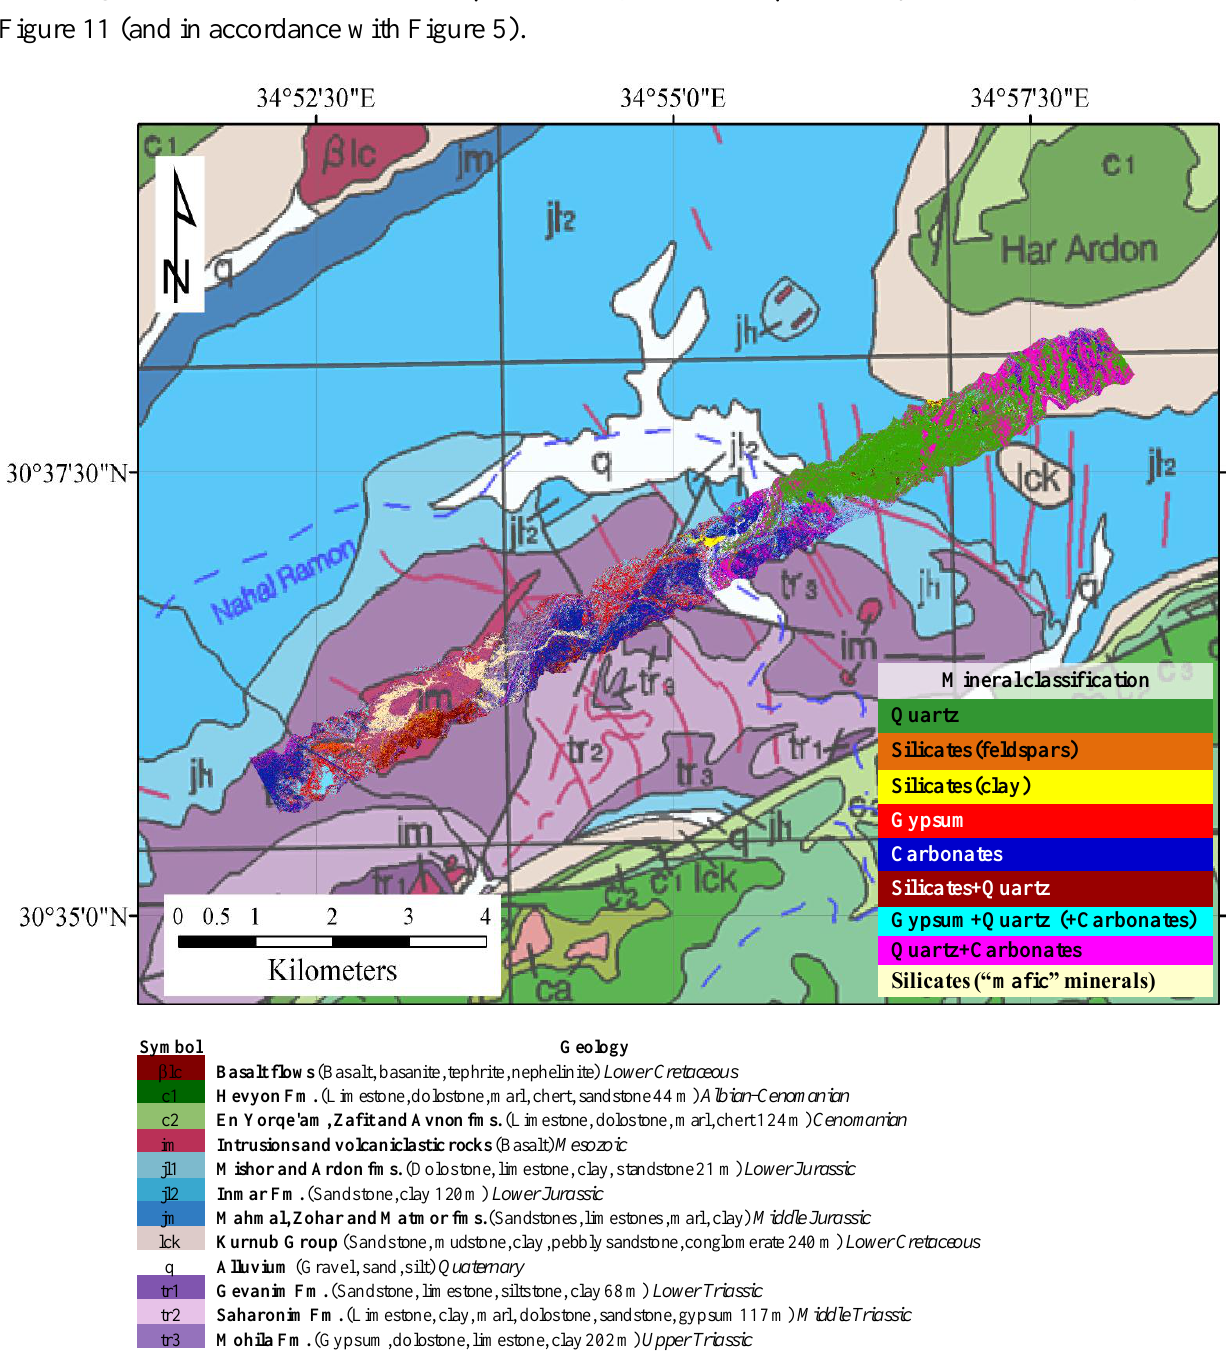
Figure 9. Mineral map of the bottom surface of Makhtesh Ramon. The “mafic” minerals refer to mineralogy similar to ROI 3 which was mapped by applying the Spectral Angle Mapper algorithm [15] with the ROI 3 Ls/Lb spectrum as the endmember